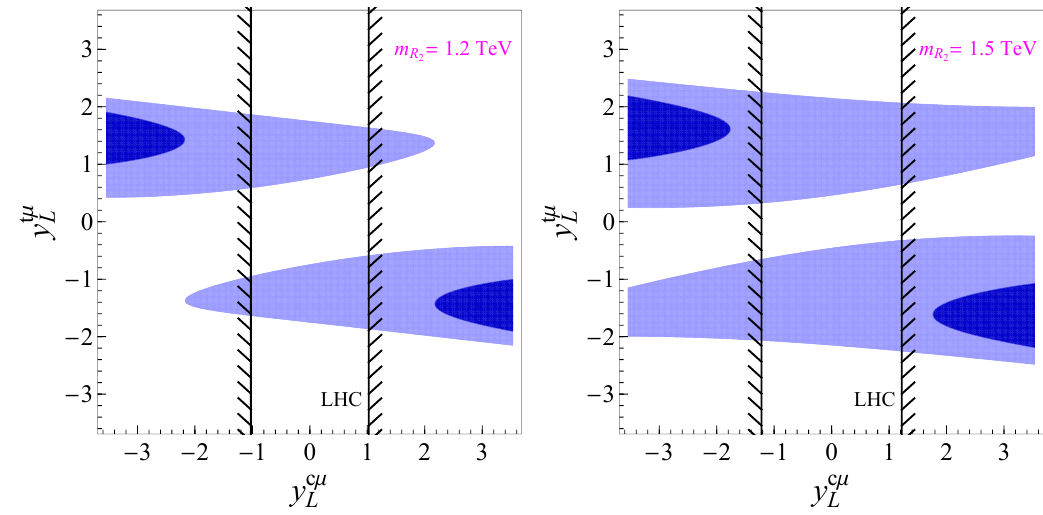
Figure 5 . Regions in plane y c(cid:22) vs. y t(cid:22) with (cid:1) (cid:31) 2 = 2 : 3(6 : 8) are plotted in dark (light) blue for m R = 1 : 2 TeV (left panel) and 1.5 TeV (right panel). We consider the b ! s‘‘ constraint [eq. (2.3)] 2 and the ones from the Z -pole observables computed in [52]. The black line denotes the LHC limits derived from pp ! (cid:22)(cid:22) data with 36 fb (cid:0) 1 , which excludes an explanation of R masses. See text for